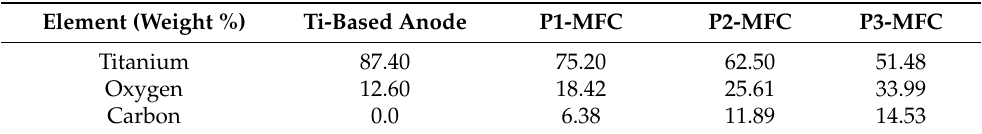
Table 1. EDS data of MFC anodes.